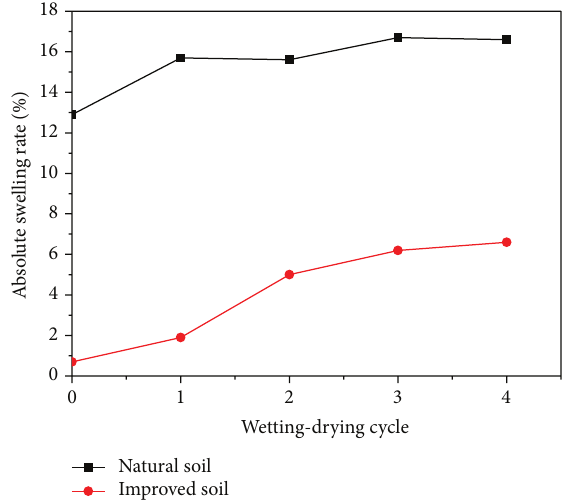
Figure 3: Relative swelling ratio trends of the natural soil and improved